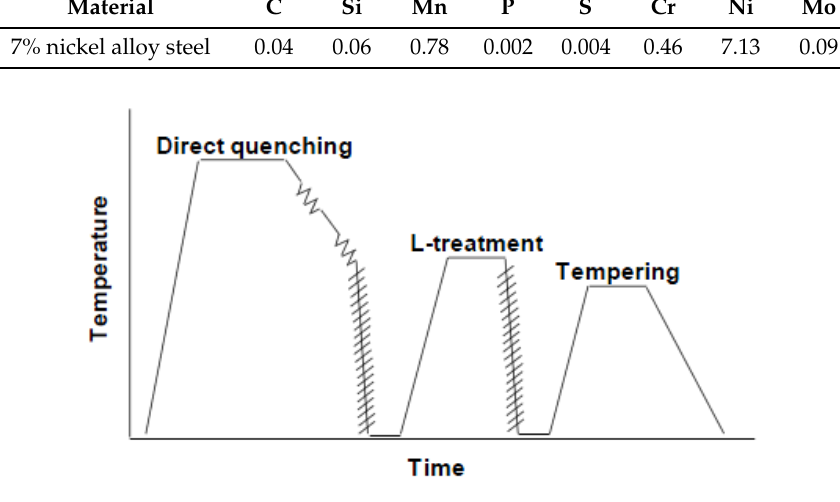
Figure 2. Schematic illustration of the manufacturing processes [9].